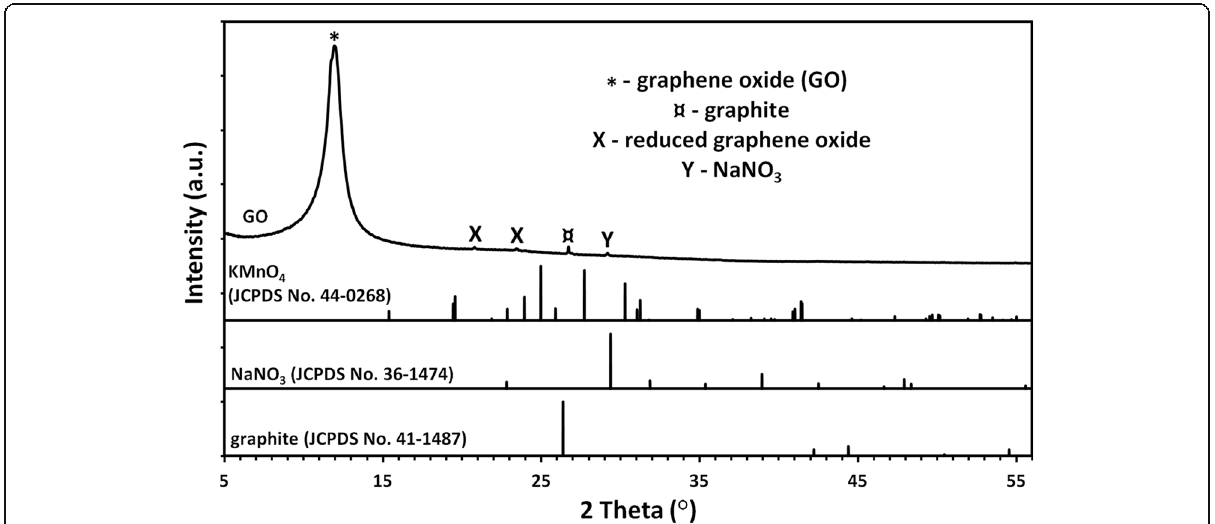
Fig. 1 X-Ray diffraction patterns of GO powders. The phase analysis of the GO sample revealed the presence of impurities coming from trace quantities of graphite, sodium nitrate, and probably a reduced form of graphene oxide